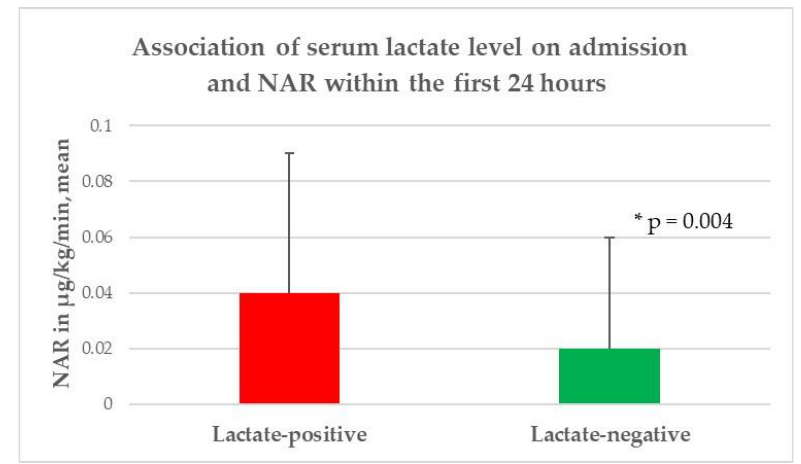
Figure 2. Association of the serum lactate level upon admission and NAR within the first 24 h . NAR: norepinephrine application rate,* level of significance.